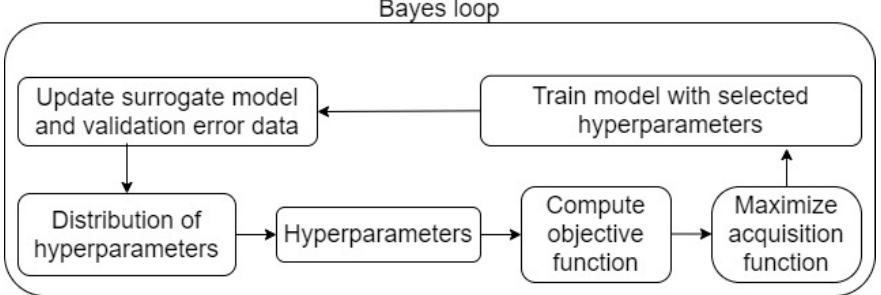
Figure 1. Schematic of the Bayes loop.